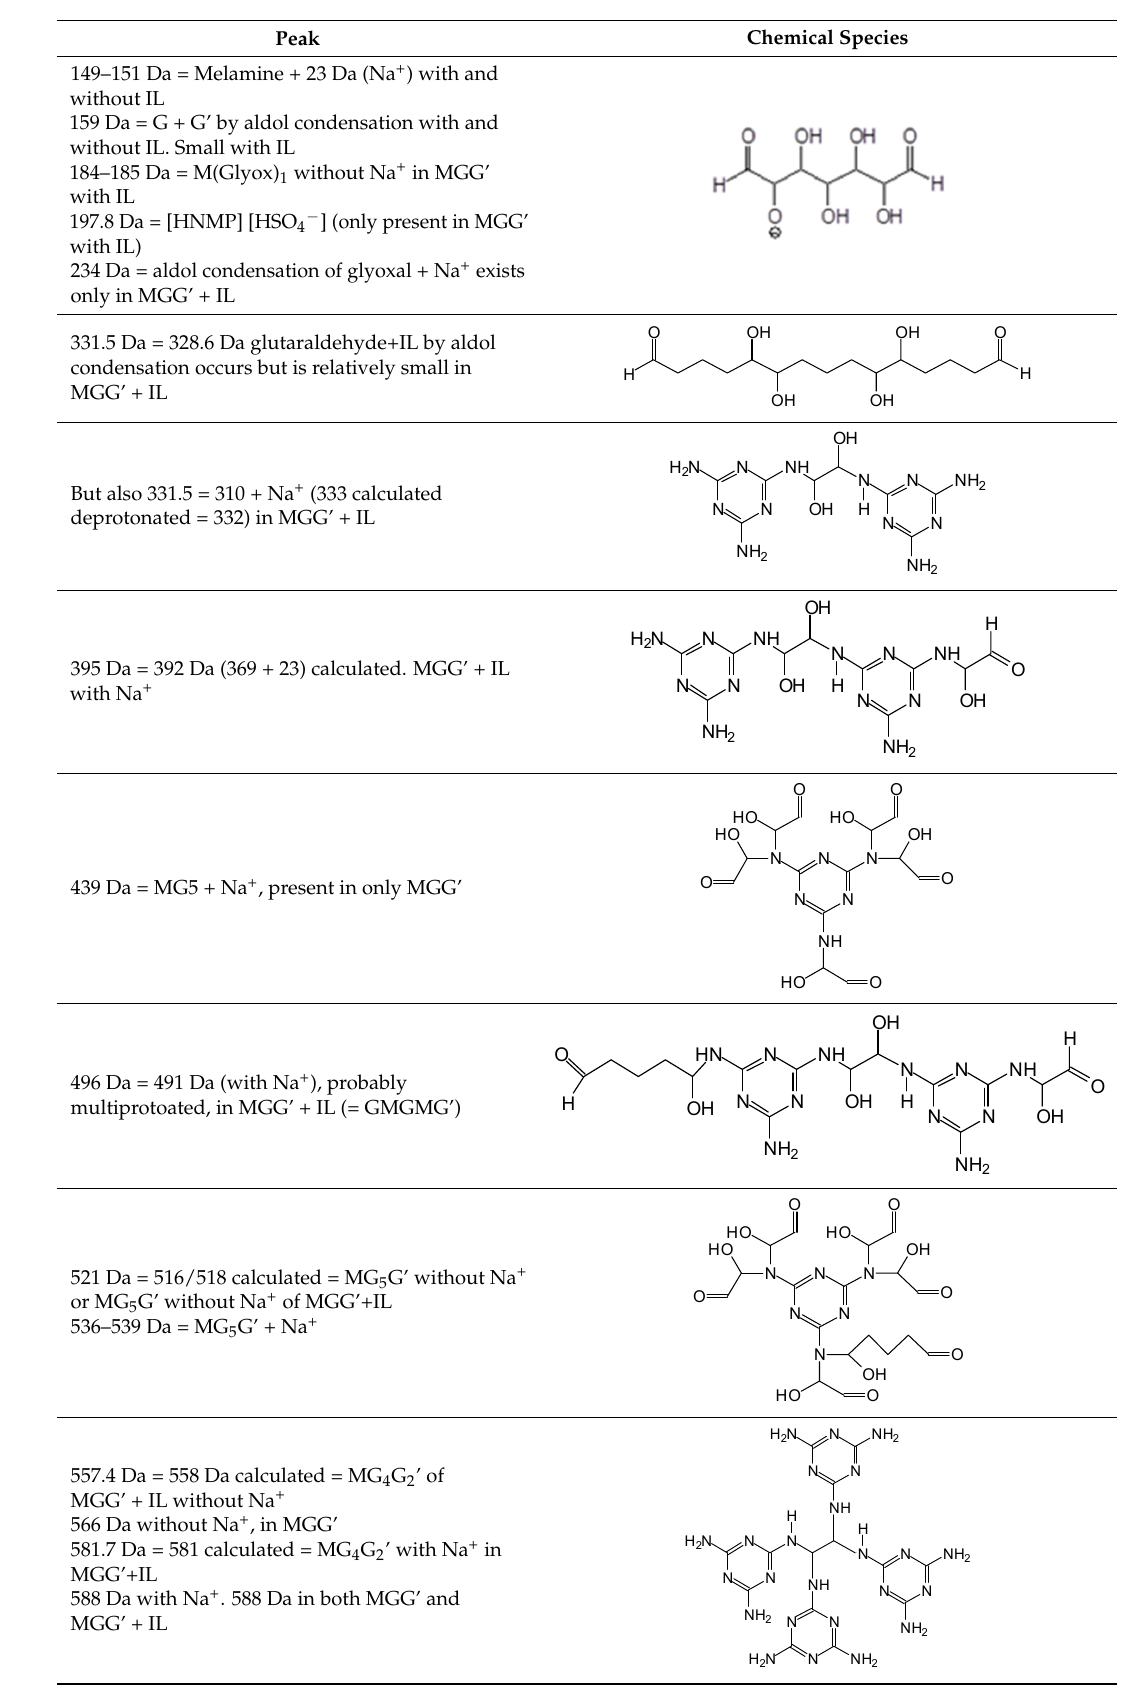
Table 6. Oligomers formed by the reaction of MGG’ with and without IL.